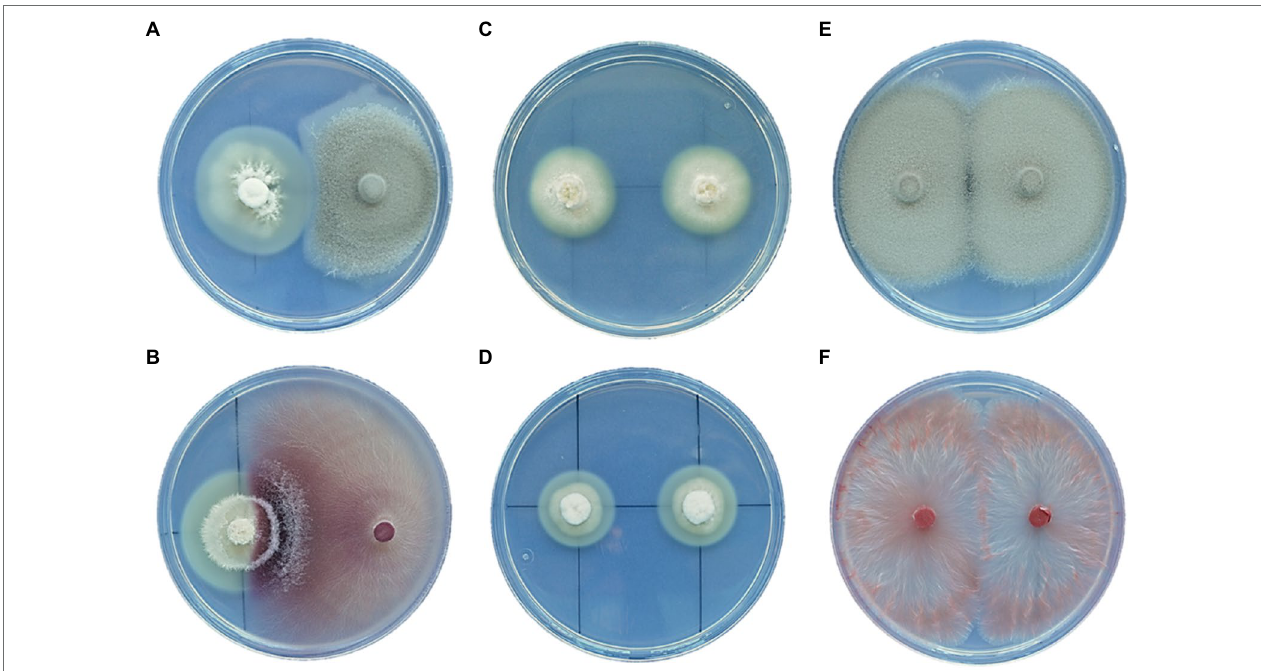
FIGURE 8 | Dual-culture interaction between E. festucae and the root endophytes P. macrospinosa (A) and F. oxysporum T48 (B) . Dual-culture control of Epichloë EB15 (C) , Epichloë TH12 (D) , P. macrospinosa T131 (E) , and F. oxysporum T48 (F) . All cultures are two weeks